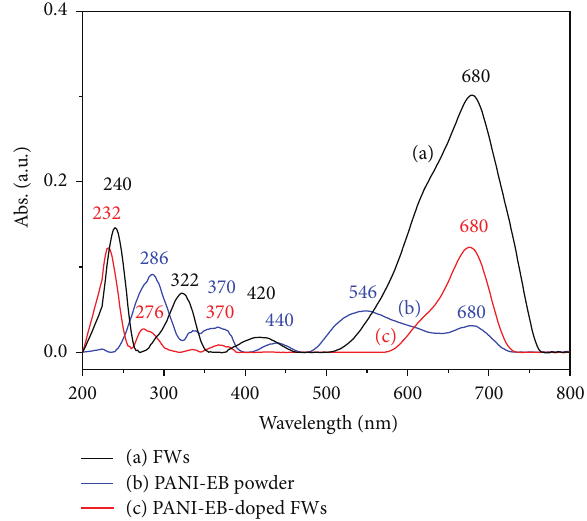
Figure 3: UV-Vis absorption spectra of (a) FWs, (b) PANI-EB powder, and (c) PANI-EB-doped